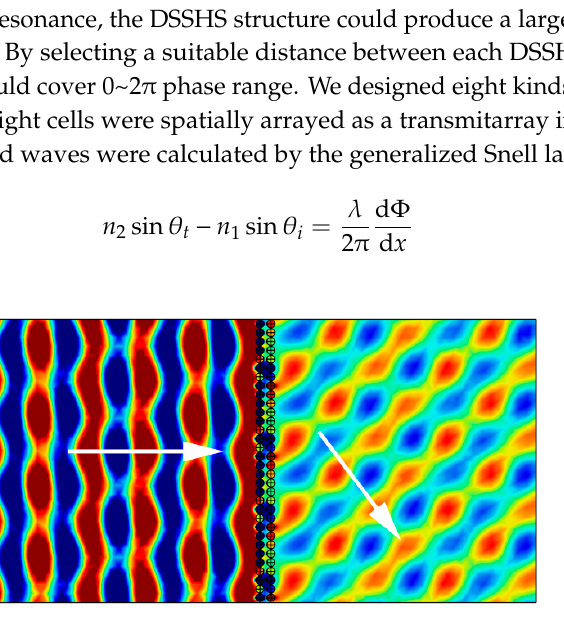
Figure 9. The transmitted acoustic field of the DSSHS metasurface. The white arrows indicate the direction of energy of acoustic waves.